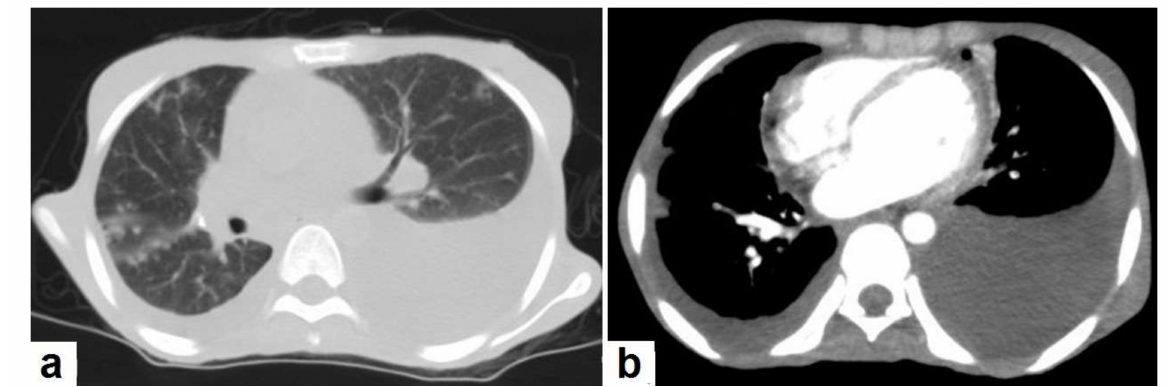
Figure 8. Active TB in a 27-year-old man (same case of Figures 2 and 5). ( a ) Axial image of chest CT shows moderate left and mild right pleural effusion with discrete pulmonary nodules in active TB. ( b ) Axial image of the mediastinal window shows moderate left and mild right pleural effusion with mild pericardial